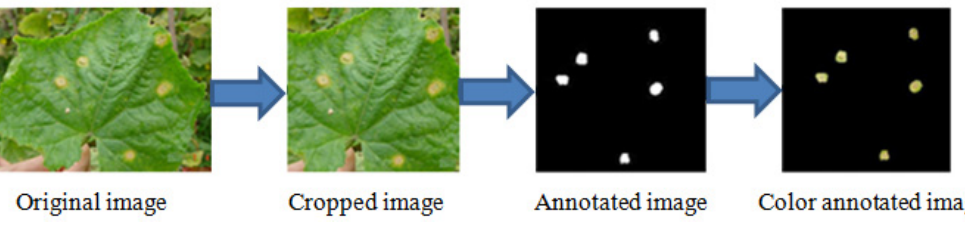
Figure 7. The cropping and annotating process.